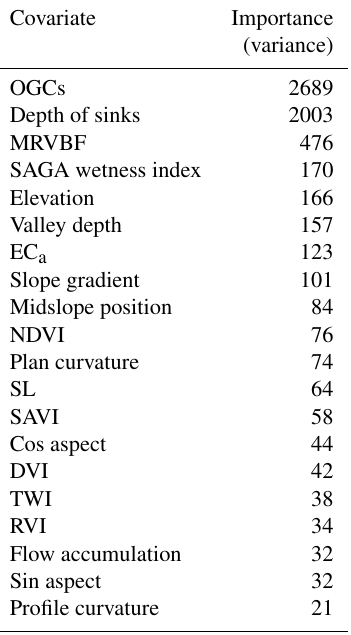
Table 6. Covariate importance of the model using OGCs in com- bination with auxiliary data for Vindum. The importance of OGCs represents the sum of the importance of the coordinate rasters at 80 different